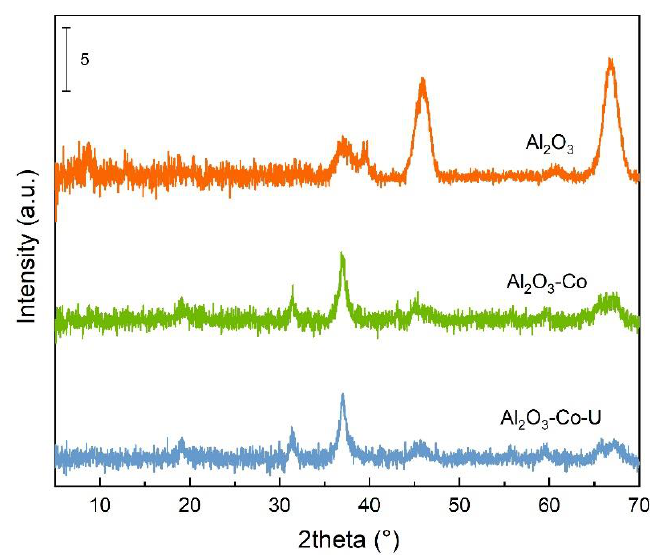
Figure A2. Powder diffraction patterns of Al 2 O 3 support, fresh and used cobalt catalyst.